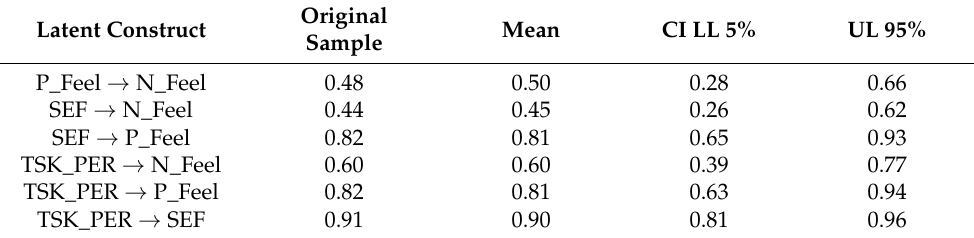
Table 7. Discriminant validity with Heterotrait-Monotrait Ratio analysis. Latent